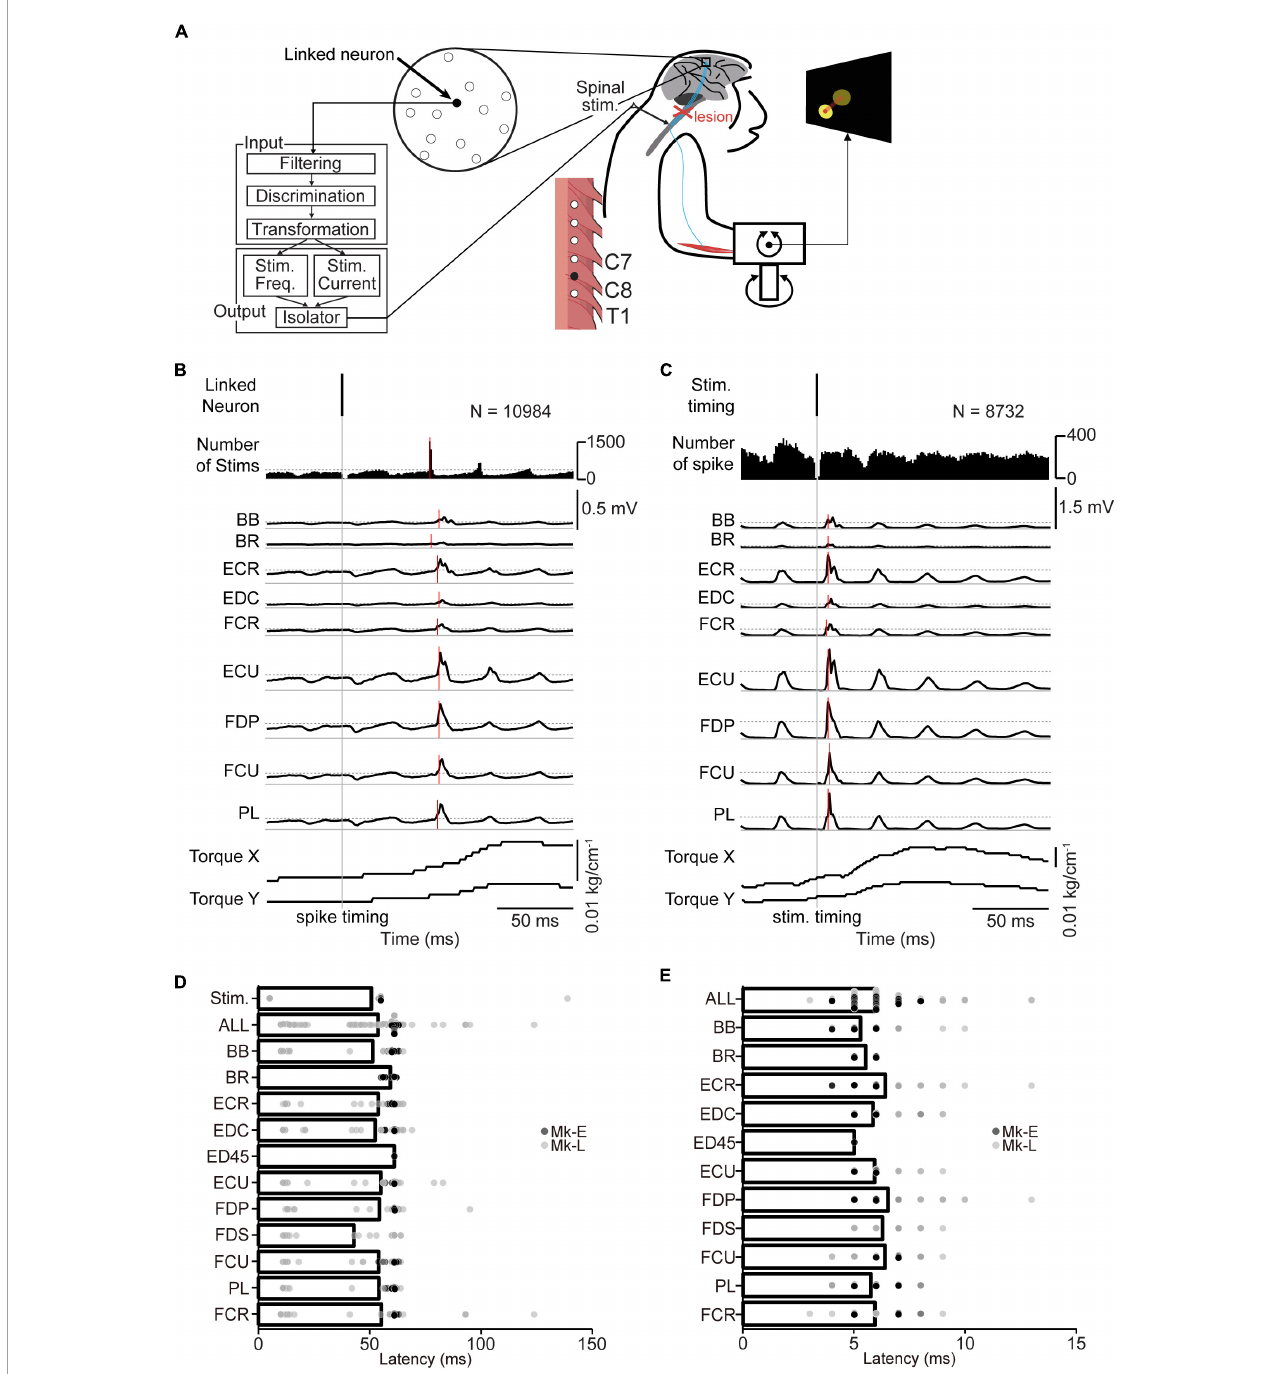
FIGURE2 The corticospinal interface. (A) Design of the corticospinal interface that translates the activity of a linked neuron to electrical stimulation of the cervical enlargement. (B) Typical examples of spike-triggered averages (SpTAs) of rectified EMGs and torque while a linked neuron was connected to the spinal site via the corticospinal interface. Traces were aligned to the spike timing of a linked neuron (vertical gray solid line). Vertical red horizontal line indicates the onset. The horizontal gray dot lines in number of stims and EMGs traces represent + 3 SDs of SpTAs calculated during the baseline period (50–0 ms preceding the spike trigger pulse), respectively. From the 1st row: spike of the linked neuron (1st row), spinal stimulation (2nd row), rectified EMG traces (3rd–11th rows), and wrist torques (12th and 13th rows). (C) Typical examples of stimulus-triggered averages (StTAs) of rectified EMGs and torque while a linked neuron was connected to the spinal site via the corticospinal interface. Traces are aligned to the timing of spinal stimulation (vertical gray solid line). Vertical red solid lines indicate the onset. The horizontal gray dot lines in EMG traces represent + 3 SDs of StTAs calculated during the baseline period (50–0 ms preceding the stimulus trigger pulse), respectively. From the 1st row: spinal stimulation (1st row), spike of the linked neuron (2nd row), EMG traces (3rd–11th rows), and wrist torques (12th and 13th rows). The data were obtained from Monkey E. (D) The onset latency of the spinal stimulation and rectified EMGs from the spike of a linked neuron [ALL: N = 564, PL and ECR: N = 62, FDS: N = 24, FDP and EDC: N = 61, ED45: N = 2, BR: N = 40, others: N = 63 (Monkey E, ALL: N = 360, FDS and ED45: N = 2, FDP and EDC: N = 38, others: N = 40; Monkey L, ALL: N = 204, PL, FDS, and ECR: N = 22, ED45 and BR: N = 0, others: N = 23)]. Bars indicate mean values. (E) The onset latency of the rectified EMGs from the spinal stimulation [ALL: N = 567, FDS: N = 25, FDP and EDC: N = 61, ED45: N = 2, BR: N = 40, others: N = 63 (Monkey E, ALL: N = 360, FDS and ED45: N = 2, FDP and EDC: N = 38, others: N = 40; Monkey L, ALL: N = 207, ED45 and BR: N = 0, others: N = 23)]. Bars indicate mean